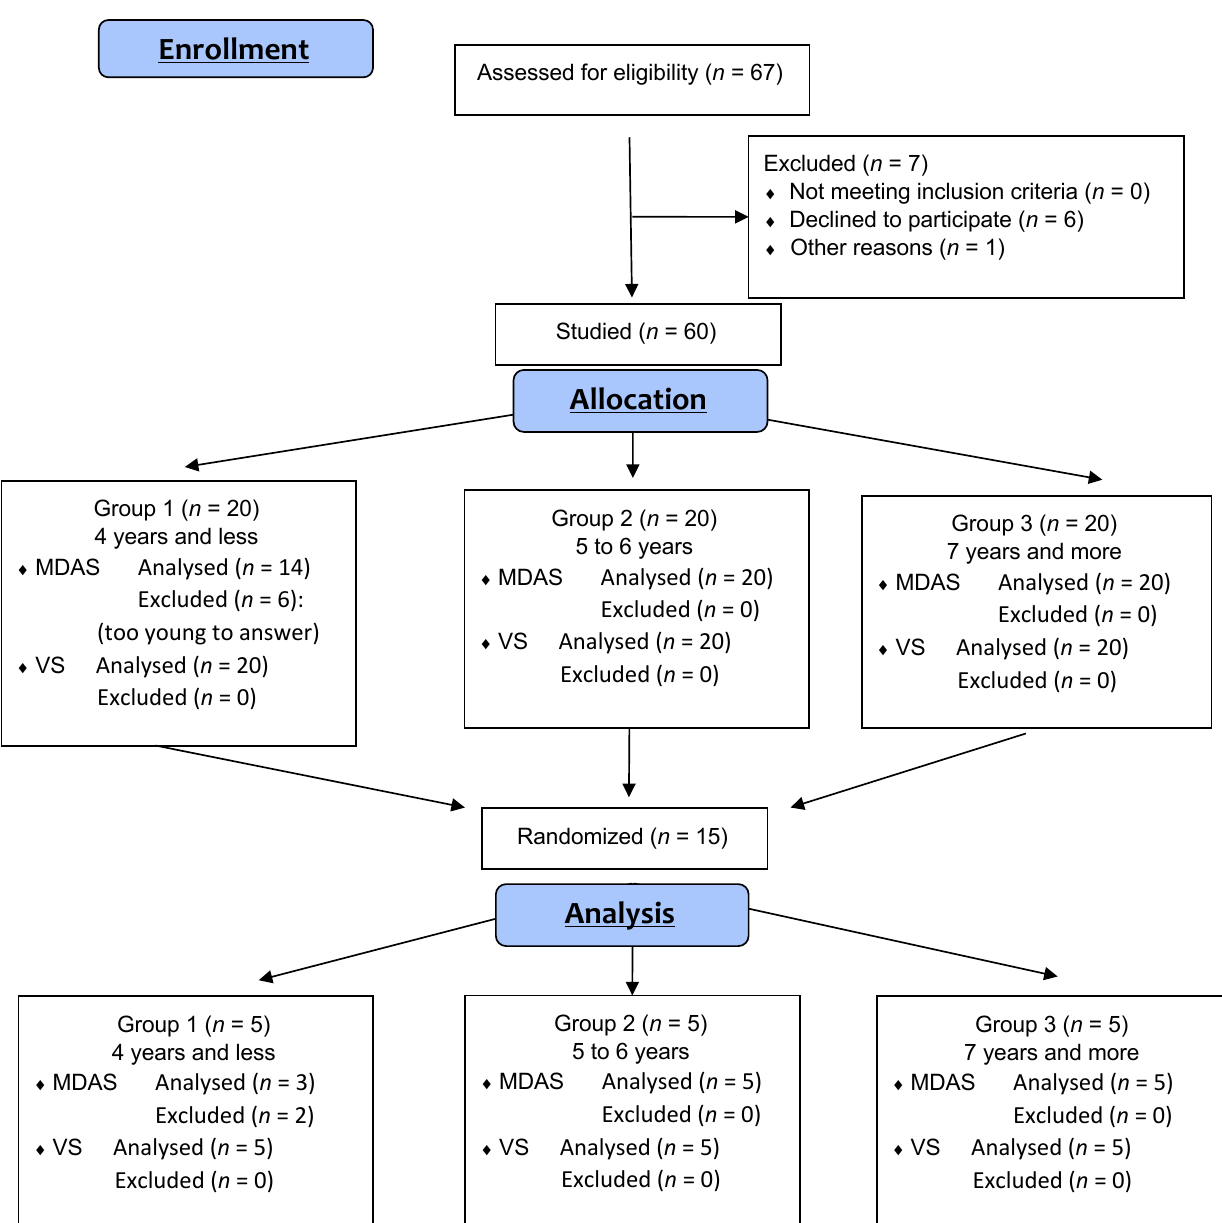
Figure 1. Flow diagram. (MDAS: Modified Dental Anxiety Scale; VS: modified Venham